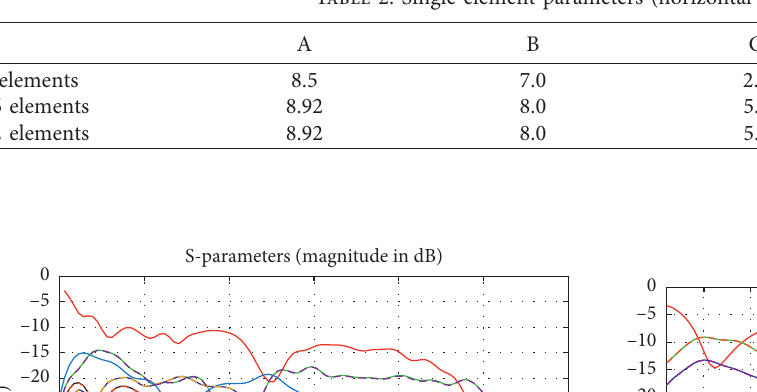
Figure 3: Microwave system of antenna arrays in horizontal polarization for (a) 8 elements, (b) 16 elements, and (c) 32 elements. Table 2: Single element parameters (horizontal